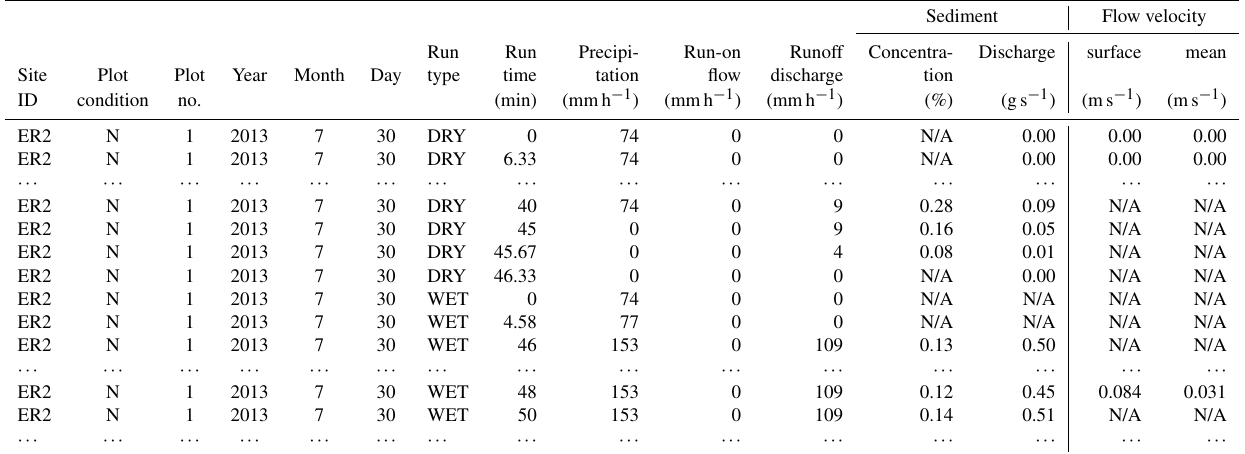
Table 2. An example of rainfall simulation data organization.